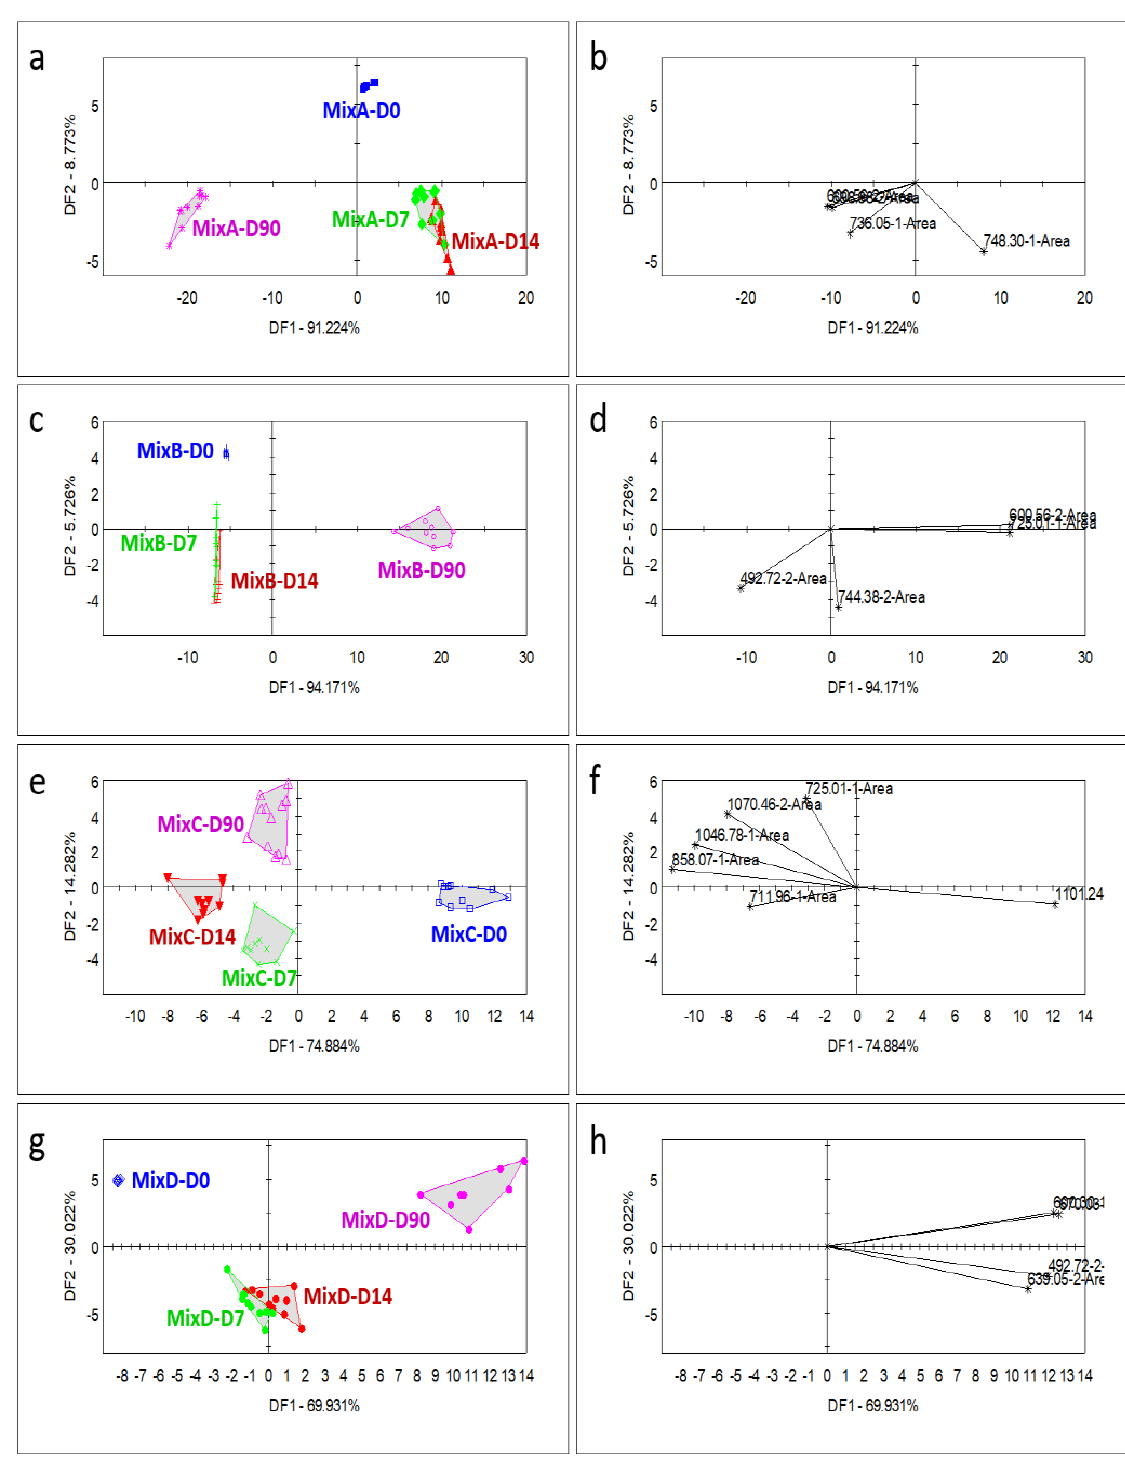
Figure 4. LDA classifications of the fermentation stages (Day 0, 7, 14, 90) within the different silage mixtures: ( a ) mixture A; ( c ) mixture B; ( e ) mixture C; ( g ) mixture D, and the loading plots ( b , d , f , h ) showing the impact of the selected dominant sensors on the relevant discriminant factors.